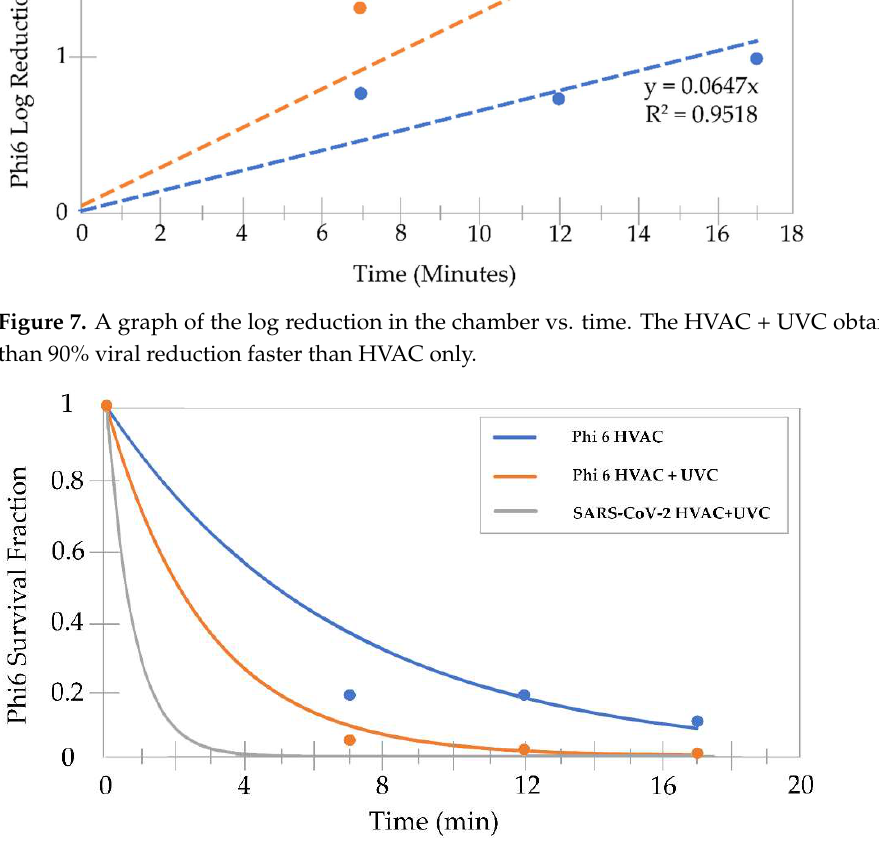
Figure 8. Curves of surviving fraction of Phi6 vs. the sampling time. Log fits of the data are shown vs. this data as well as the extrapolation, based on these fits, to the disinfection rate for SARS-CoV-2 which required less time due to wavelength sensitivity.